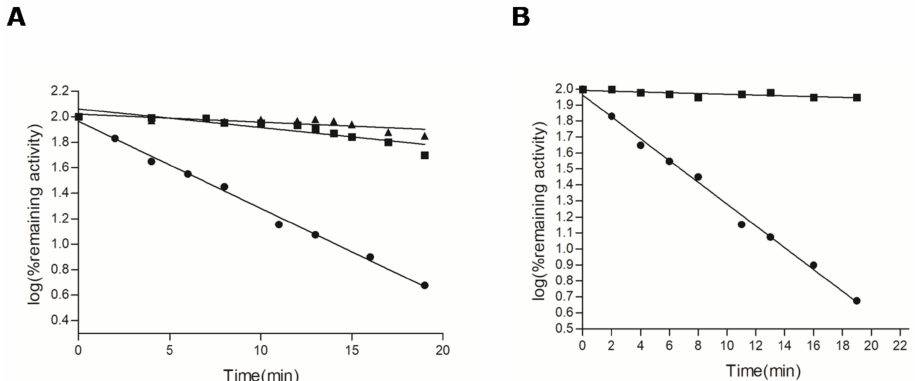
Figure 5. The effects of nucleotides and mutation at position 174 on the inactivation of Cb FDH by AMPS-HDB. (A) Time course of inactivation of Cb FDH by AMPS-HDB (0.1 mM) at pH 8.0 and 25 ◦ C, in the absence ( • ) or in the presence of NAD + ( (cid:4) , 1 mM) or NADH ( (cid:78) , 1 mM). (B) Inactivation of the mutant enzyme Arg174Asn by AMPS-HDB (0.1 mM) ( (cid:4) ). At the times indicated, aliquots were withdrawn and assayed for enzymatic activity.